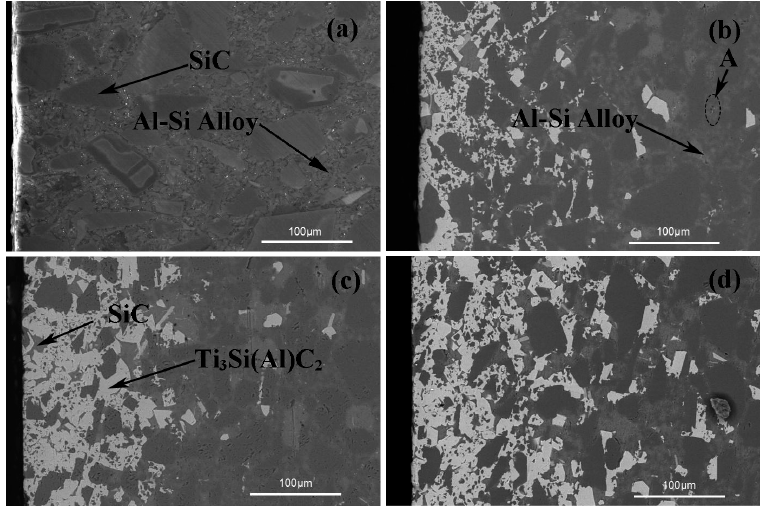
Figure 2. Cross-sectional backscattered electron (BSE) images of the reaction layers on the composites infiltrated by the Al–Si–xTi alloy (Si: 10 wt.%) with Ti contents (wt.%) of ( a ) 0, ( b ) 5, ( c ) 10, and ( d ) 15. Table 2. Energy-dispersive spectroscopy (EDS) analysis results of the different regions in the interfacial reaction layer shown in Figure 2. Region AlK (at.%) SiK (at.%) CK (at.%) TiK (at.%)